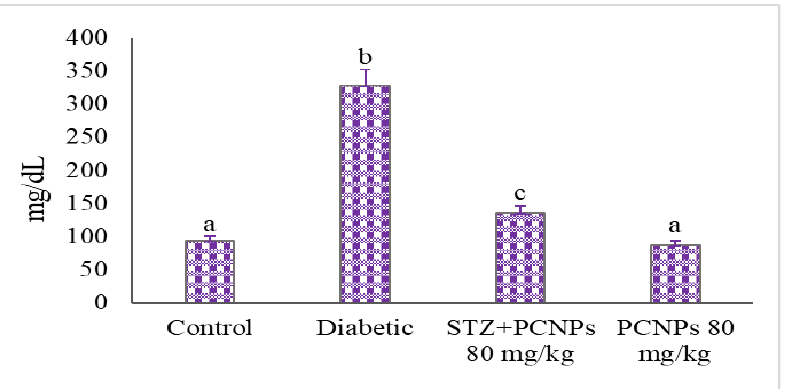
Figure 1. Activities of PCNPs on plasma glucose of experimental and control group. Values are means ± SD for six rats at p < 0.05 (DMRT). a PCNPs alone treated group compared with control group. b Diabetic group compared with control group. c Treatment group compared with diabetic control.